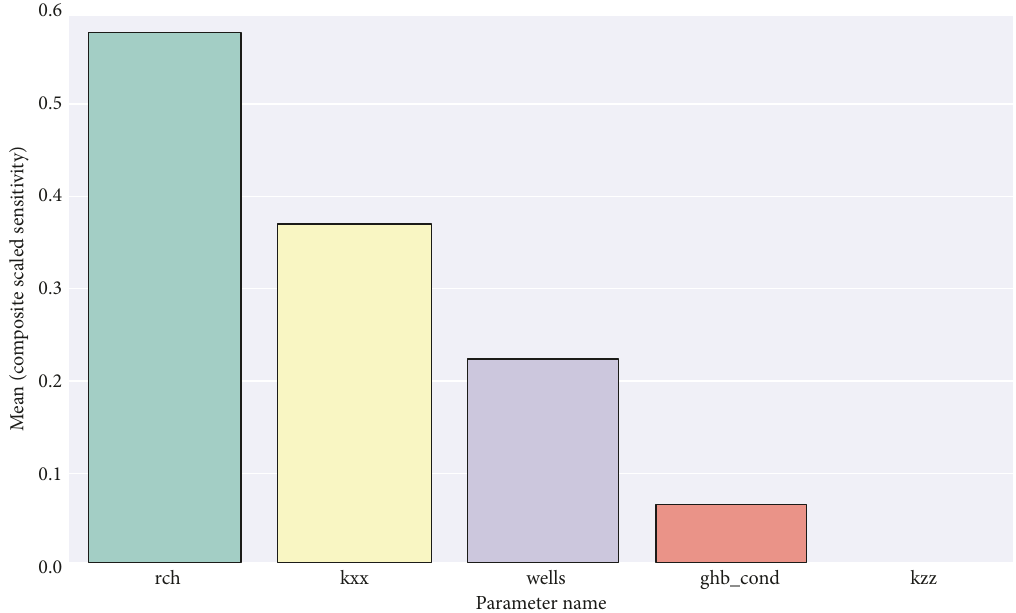
Figure 6: Values of the Composite Scaled Sensitivity for the model parameters considered as the most sensitive